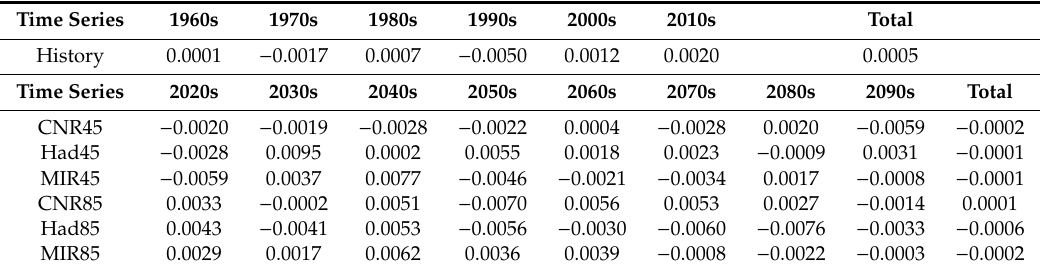
Table 5. The interdecadal linear slope for the monthly SPEI-3 historically and in the